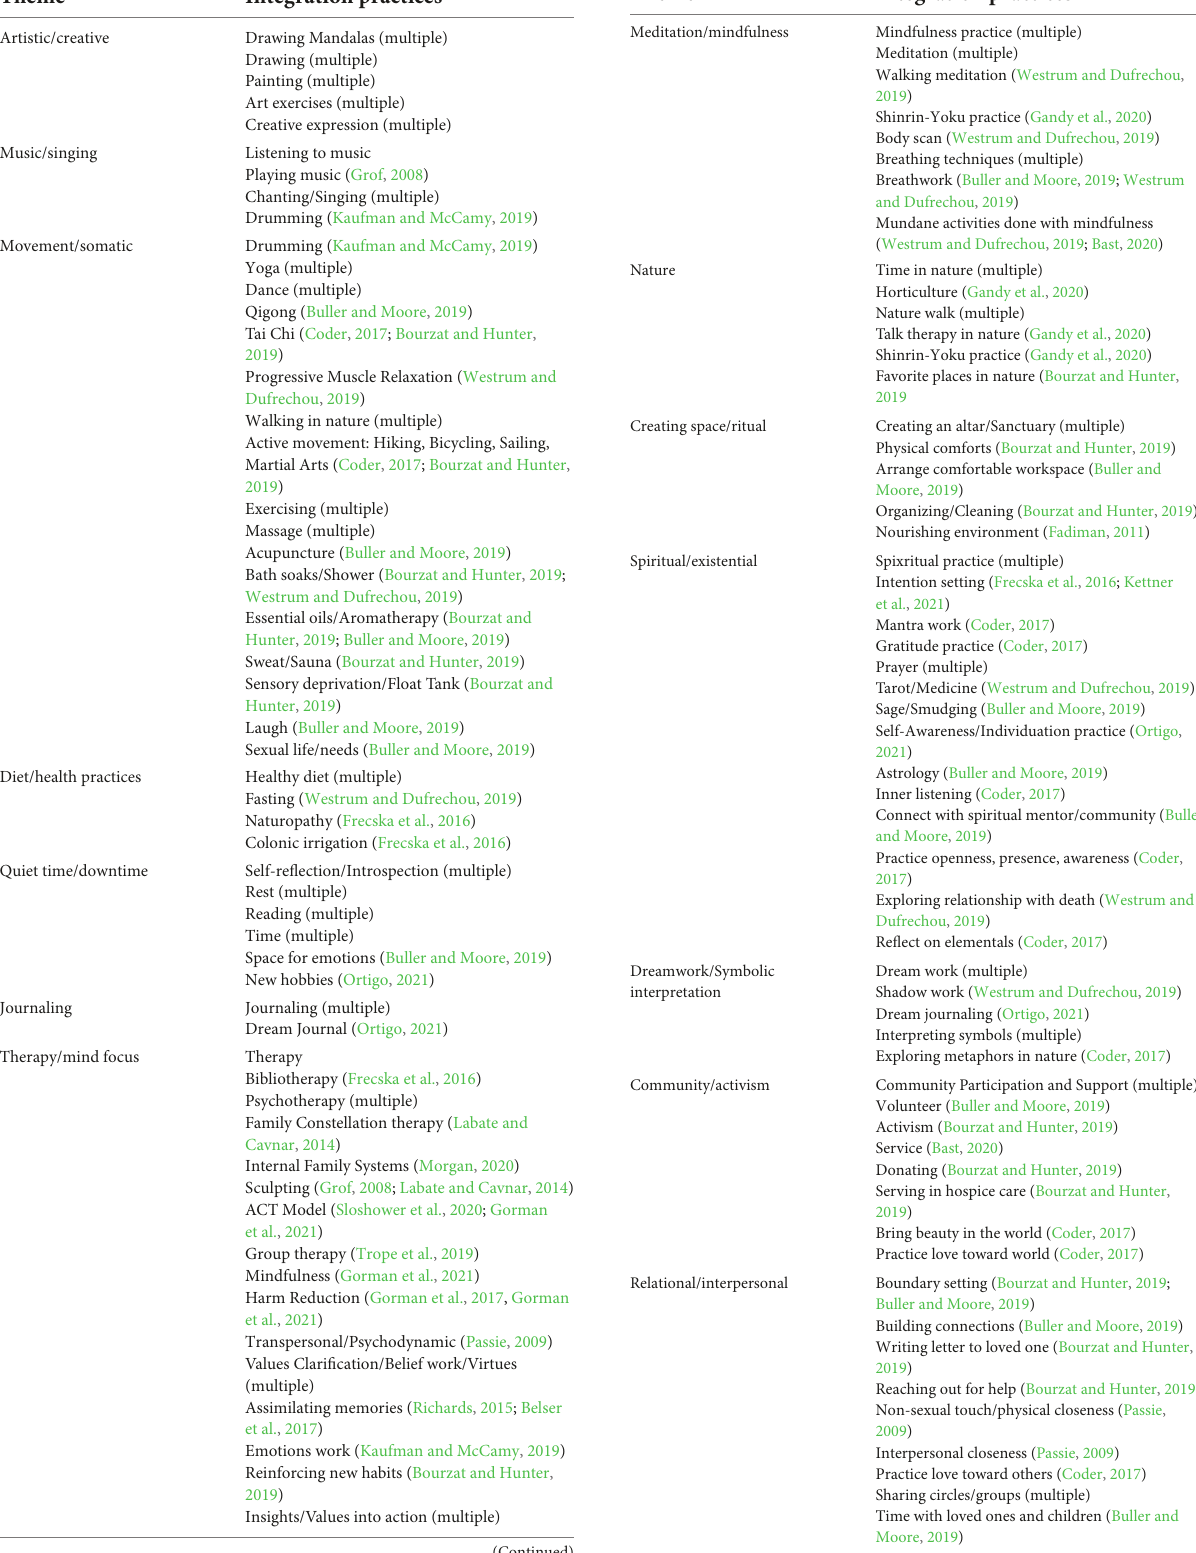
TABLE 2 Summary of integration practices by